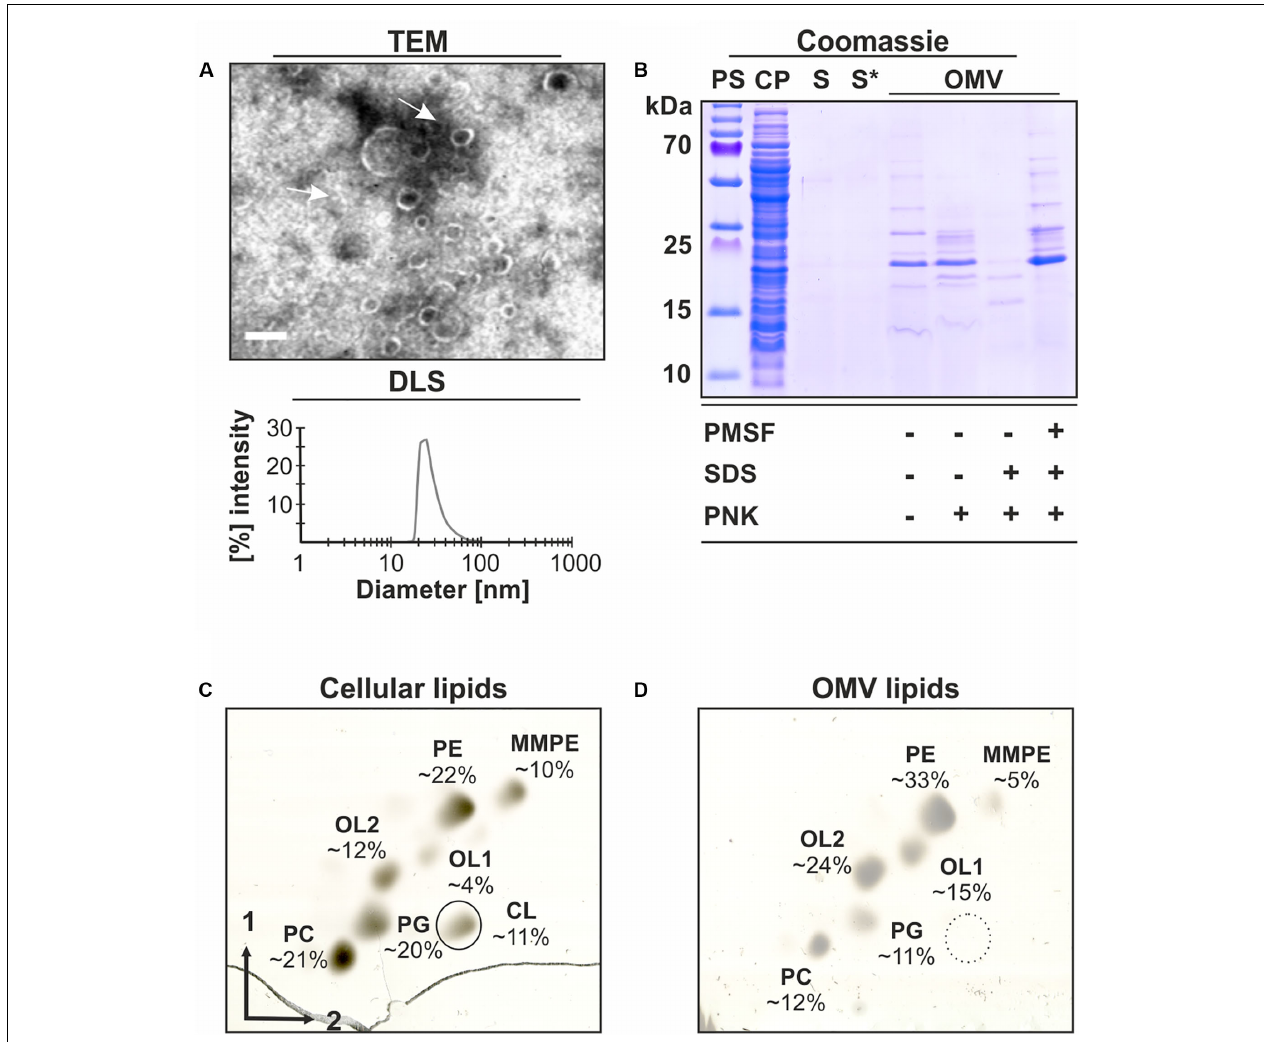
FIGURE 1 | Characterization of OMVs isolated from A. tumefaciens culture supernatants. A. tumefaciens C58 cultures were grown in LB medium to an OD 600 value of 1.0 before OMVs were isolated from the cell-free culture supernatants and further characterized. (A) Transmission electron microscopy (TEM) images and size distribution of OMVs determined by dynamic light scattering (DLS). The arrows indicate isolated OMVs. Scale bar: 100 nm. (B) SDS-PAGE analysis and proteinase K (PNK)-protection assays of OMV proteins. (C) Analysis of cellular and (D) OMV lipids by 2-dimensional TLC. Lipids were visualized and quantitated by copper (II) sulfate charring. Lipid standards were used to assign the phospholipid species. PS, protein standard; CP, cell pellet; S, cell-free culture supernatant; S*, S after ultracentrifugation containing secreted soluble proteins; OMV, pellet containing outer membrane vesicles after ultracentrifugation; CL, cardiolipin; PE, phosphatidylethanolamine; MMPE, monomethyl-PE; PC, phosphatidylcholine; PG, phosphatidylglycerol; and OL1/2, ornithine lipids